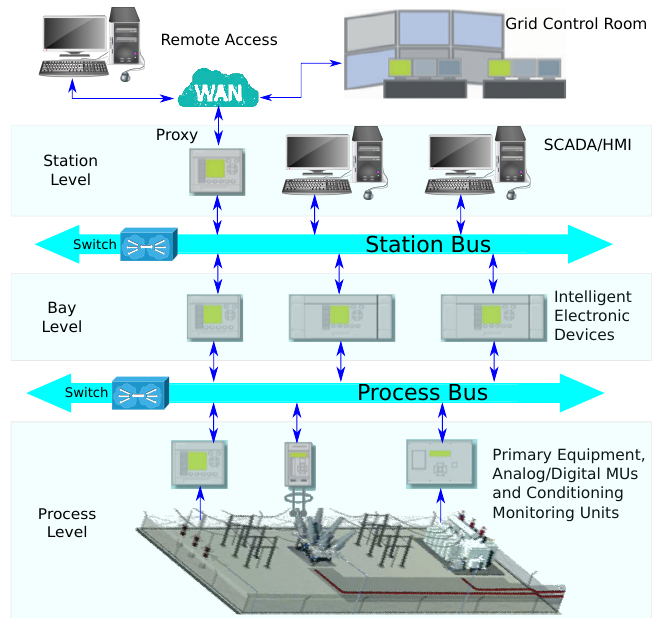
Figure 1. IEC 61850 automation levels [12].